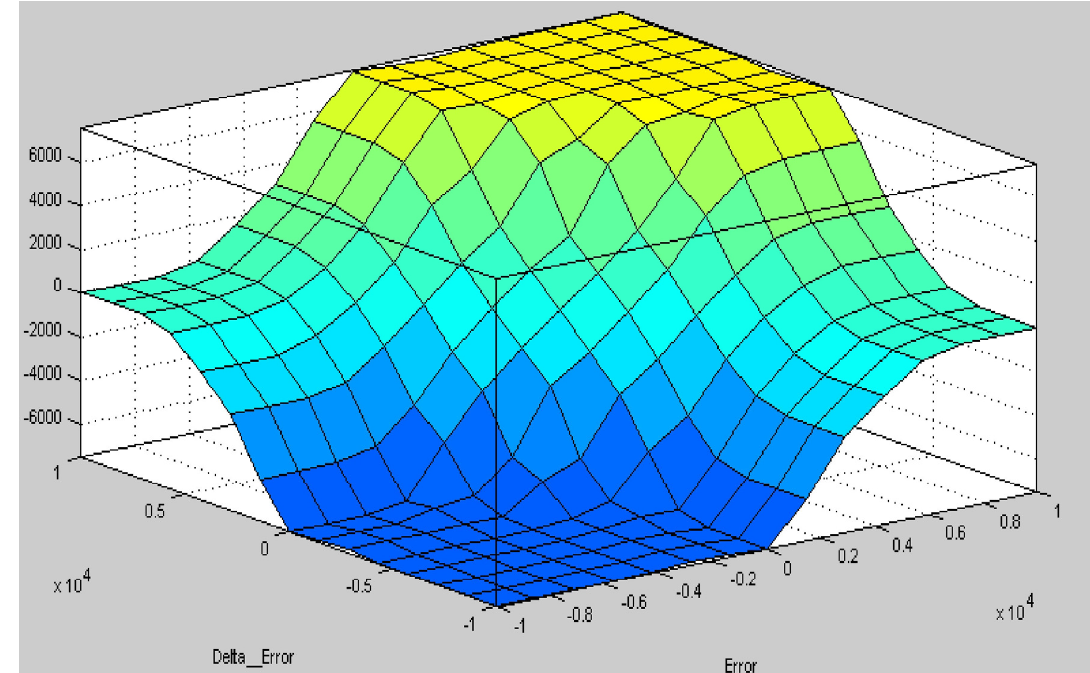
Figure A4. Surface.